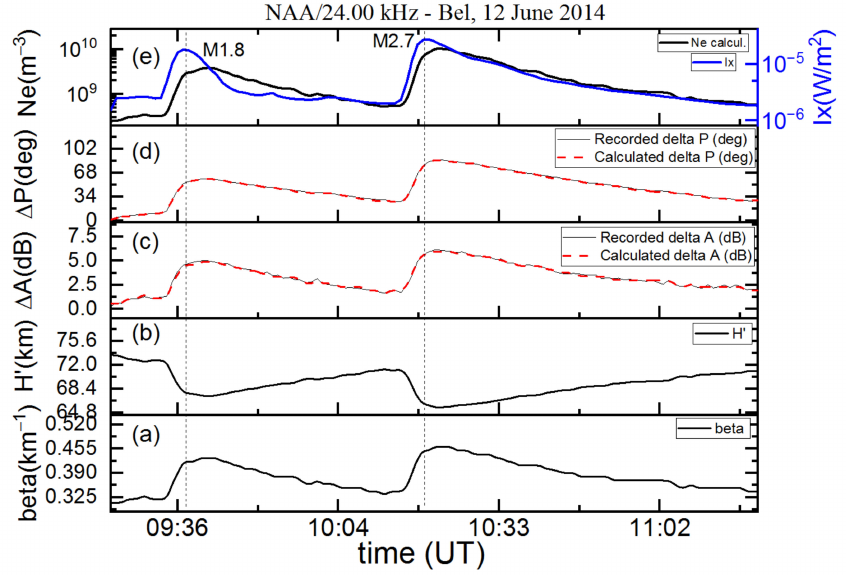
Figure 6. Variations of the sharpness β ( a ), effective reflection height H (cid:48) ( b ), VLF amplitude ( c ) and phase ( d ) recorded and simulated, reference height electron density ( e ) and X-ray flux (on the right axis ( e )), during the occurrence of two successive M-class SFs on 12 June